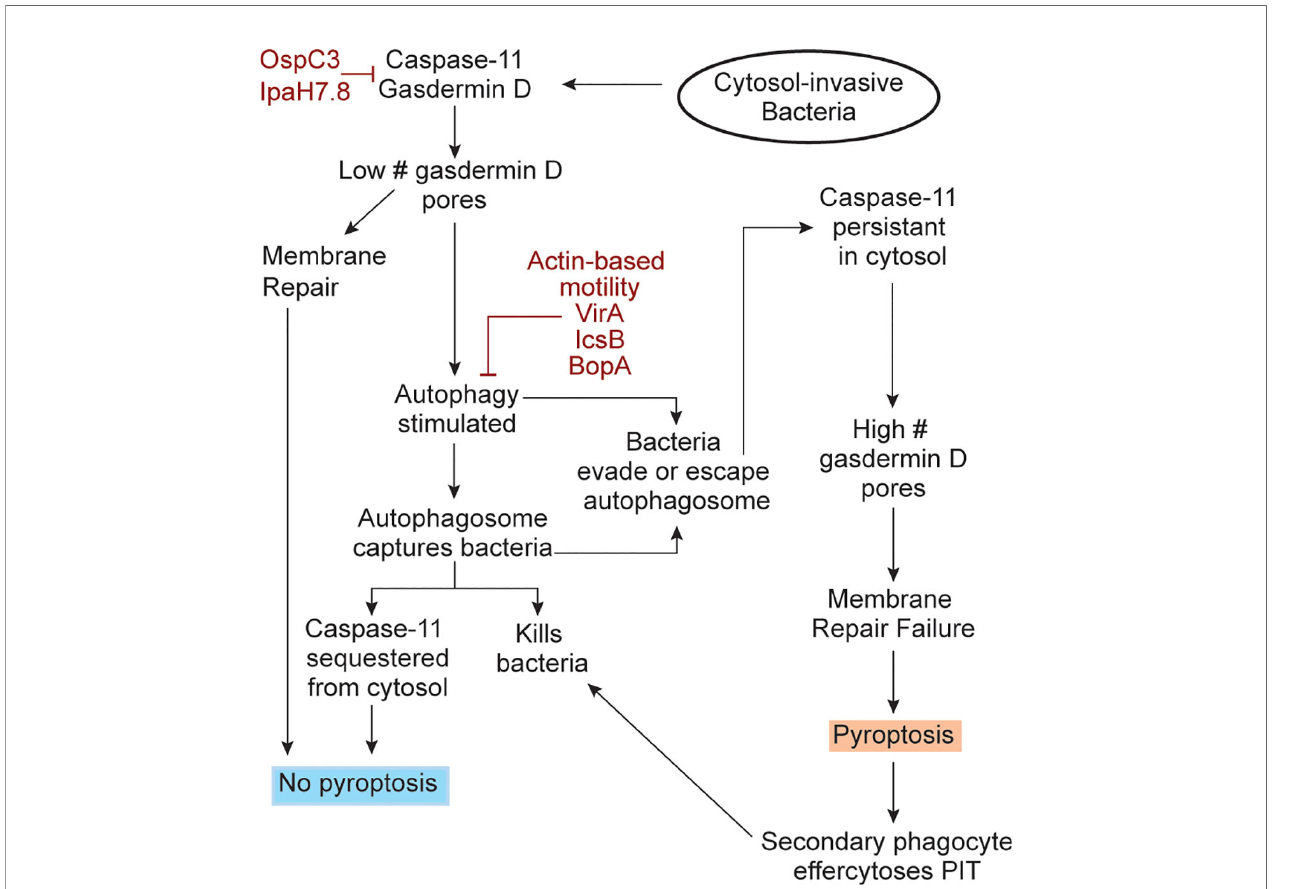
FIGURE 1 | An algorithmic response to cytosol-invasive bacteria. Upon bacterial invasion into the cytosol, caspase-11 is activated by bacterial LPS. Caspase-11 then activates gasdermin D and both simulate the autophagy response. Gasdermin D inserts pores into nearby organelles, such as the mitochondria. The resulting ROS release into the cytosol stimulates autophagy, which captures cytosolic bacteria. There are two signi fi cant consequences of this. First, the bacteria can now be killed by the autophagosome. Second, caspase-11 should be simultaneously sequestered from the cytosol and if so, caspase-11 will no longer cleave gasdermin D, thereby preventing pyroptosis. Sequestering of caspase-11 should terminate the gasdermin D cleavage process, and the already generated low amount of gasdermin D pores can be removed from the plasma membrane by membrane repair. If bacterial use virulence factors evade or escape autophagic defenses (burgundy), caspase- 11 activity should persist in the cytosol and copious quantities of gasdermin D are expected to be activated. These gasdermin D pores will now insert into the plasma membrane in suf fi cient quantities and cause pyroptosis. After pyroptosis, the dead cell becomes a pore-induced intracellular trap (PIT) that restrains the bacterium. Secondary phagocytes will be recruited to efferocytose the PITs and the bacteria trapped within it, therefore killing the bacteria. The bacterial virulence factors that inhibit caspase-11, gasdermin D, and the autophagy pathway are shown (burgundy